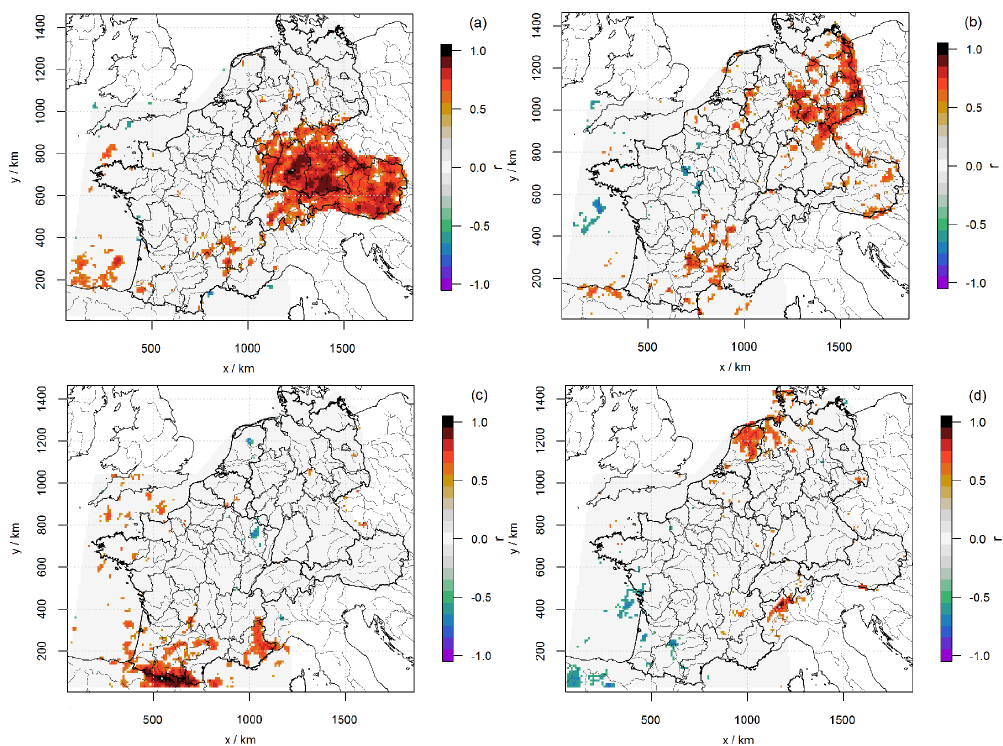
Figure 11. Spatial correlation (Spearman’s coefficient r s ) of the annual numbers of thunderstorm days with respect to different reference grid cells (indicated by a gray dot in each map) situated between the Black Forest and Swabian Jura (a) , north of the Ore Mountains (b) , on the southern side of the Pyrenees (c) , and southwest of Ticino (d) . Values that are not statistically significant (Si = 95%) have been set to